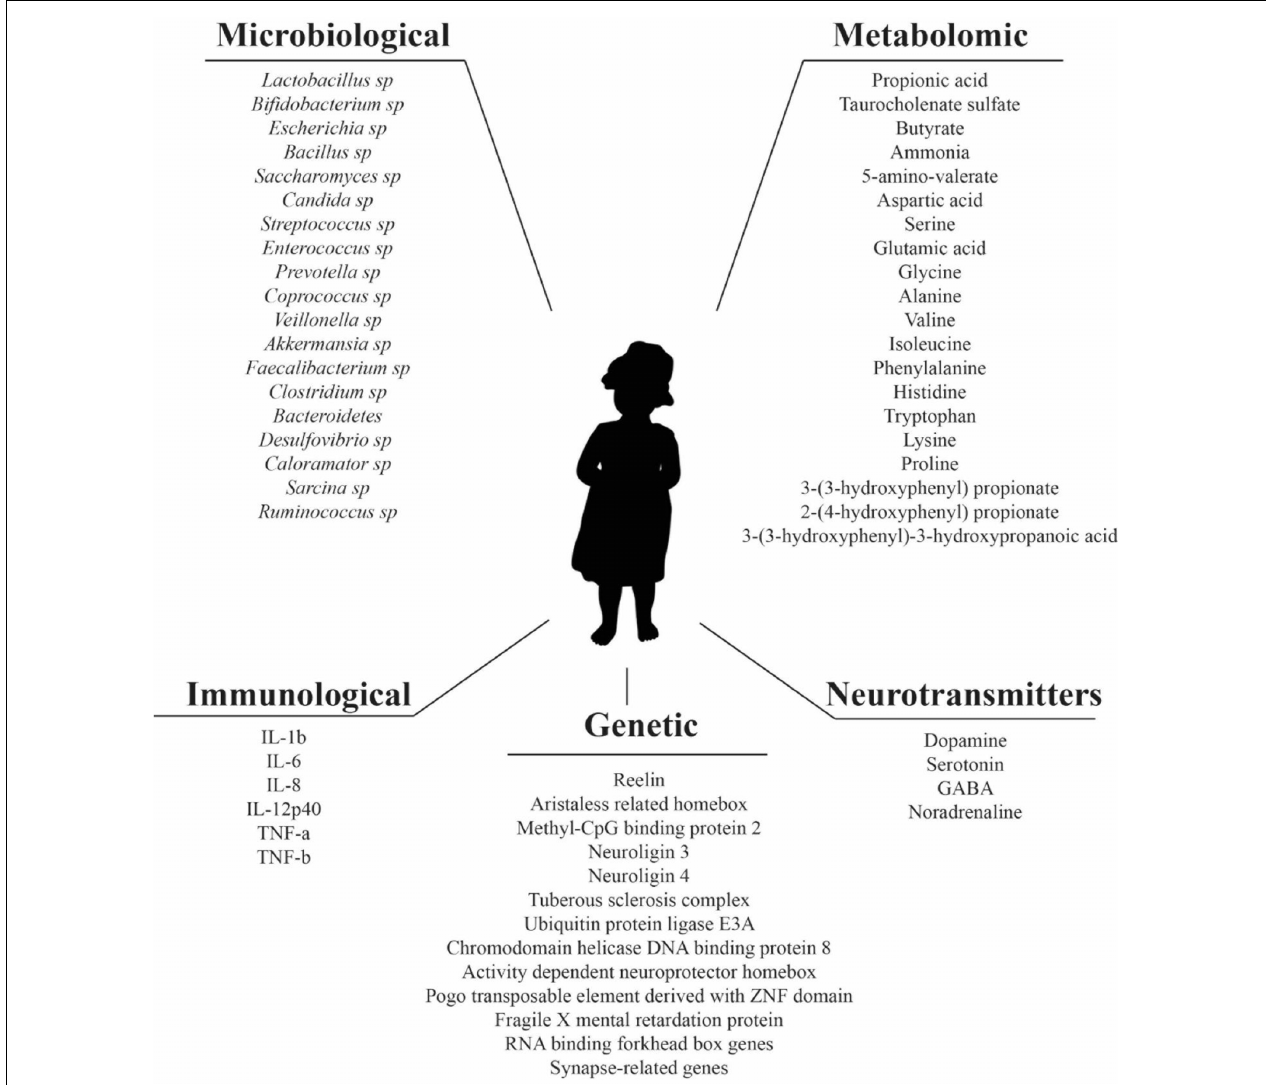
FIGURE 1 | Microbiological, metabolomic, immunological, genetic factors, and neurotransmitters reported in literature as altered in ASD